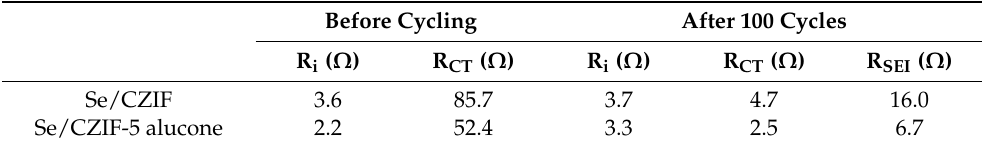
Table 1. EIS parameters obtained by fitting the Nyquist plots of Se/CZIF and Se/CZIF-5 alucone after 100 cycles. Before Cycling After 100 Cycles